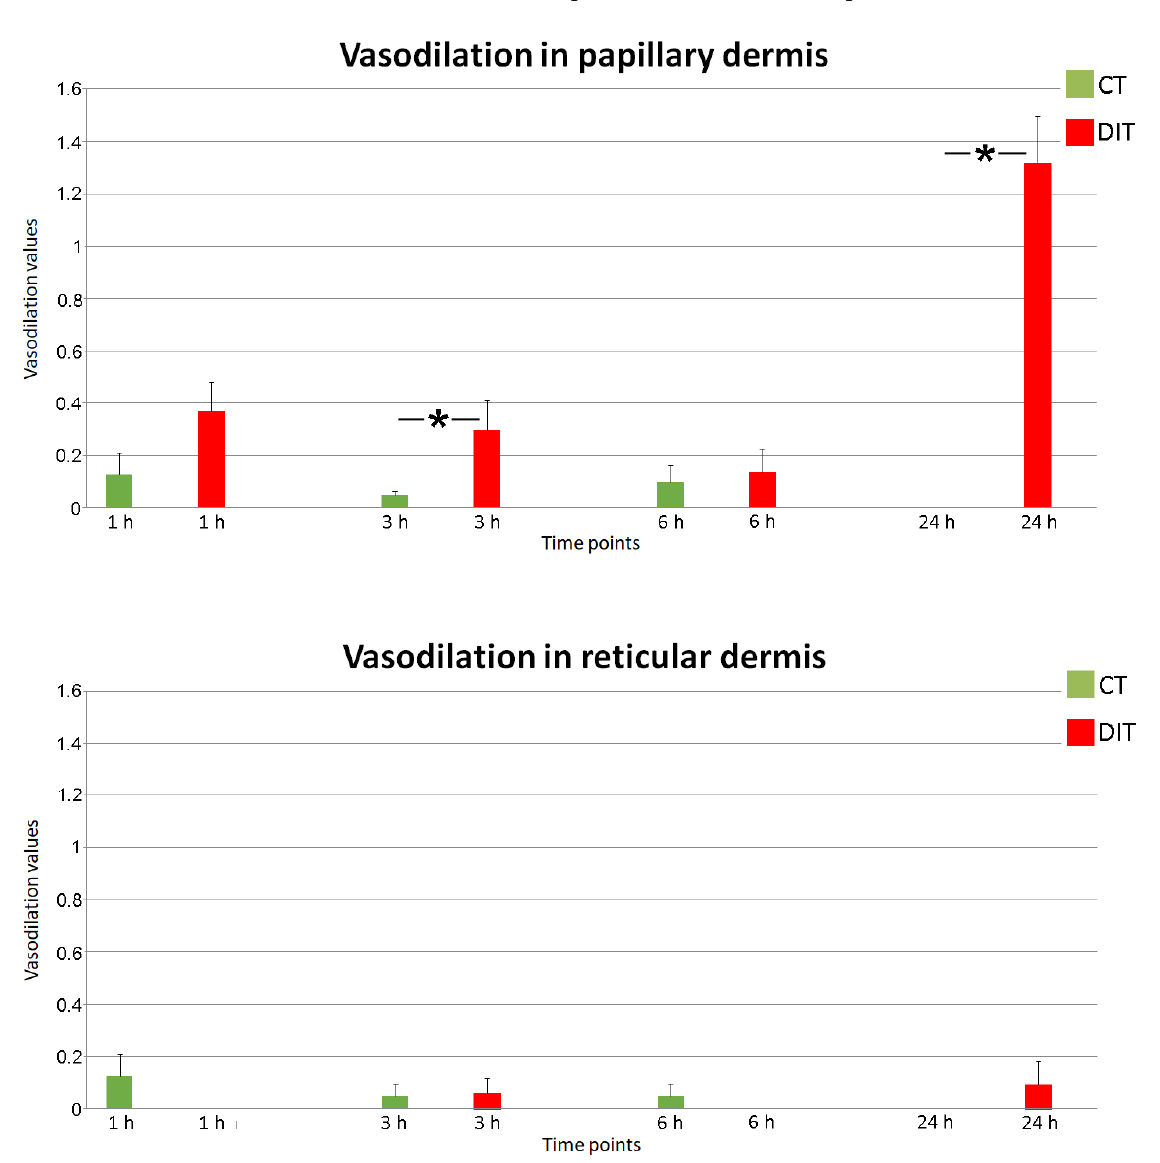
Figure 4. Mean ± standard error values of vasodilation in the papillary and reticular dermis. Asterisks indicate significant difference (3 h CT vs. 3 h DIT, p = 0.043; 24 h CT vs. 24 h DIT, p < 0.001). CT, control (untreated); DIT, dithranol-treated. Mast cells were identified using light microscopy by the acidified toluidine blue method (Figure